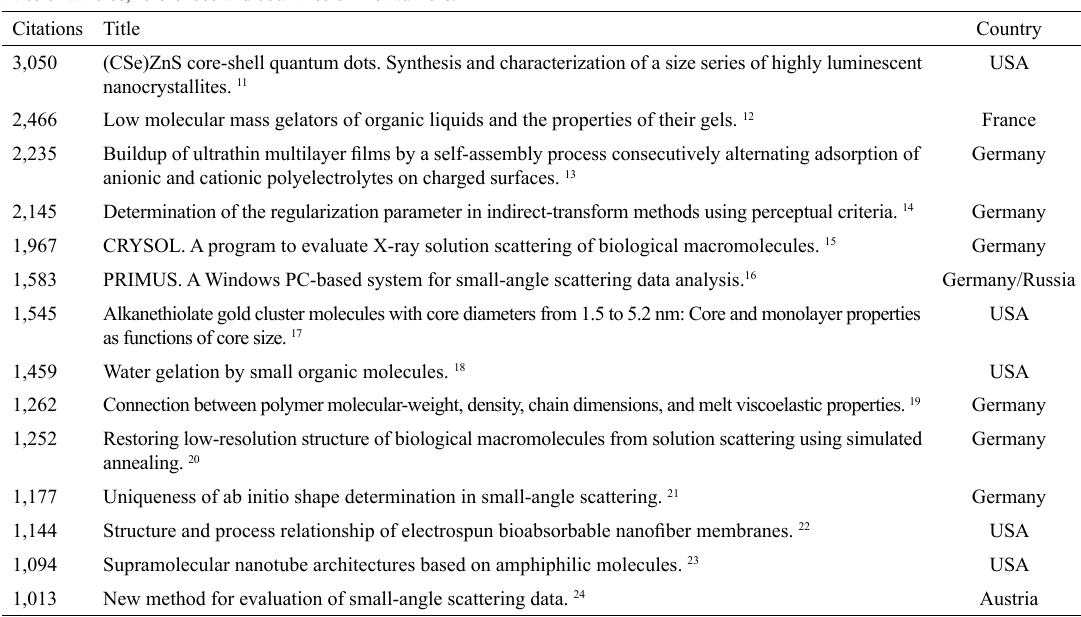
Table 3. Articles related either to SAXS or SANS with more than 1,000 citations by July 2018. The table reports citation numbers, titles of articles, references and countries of first